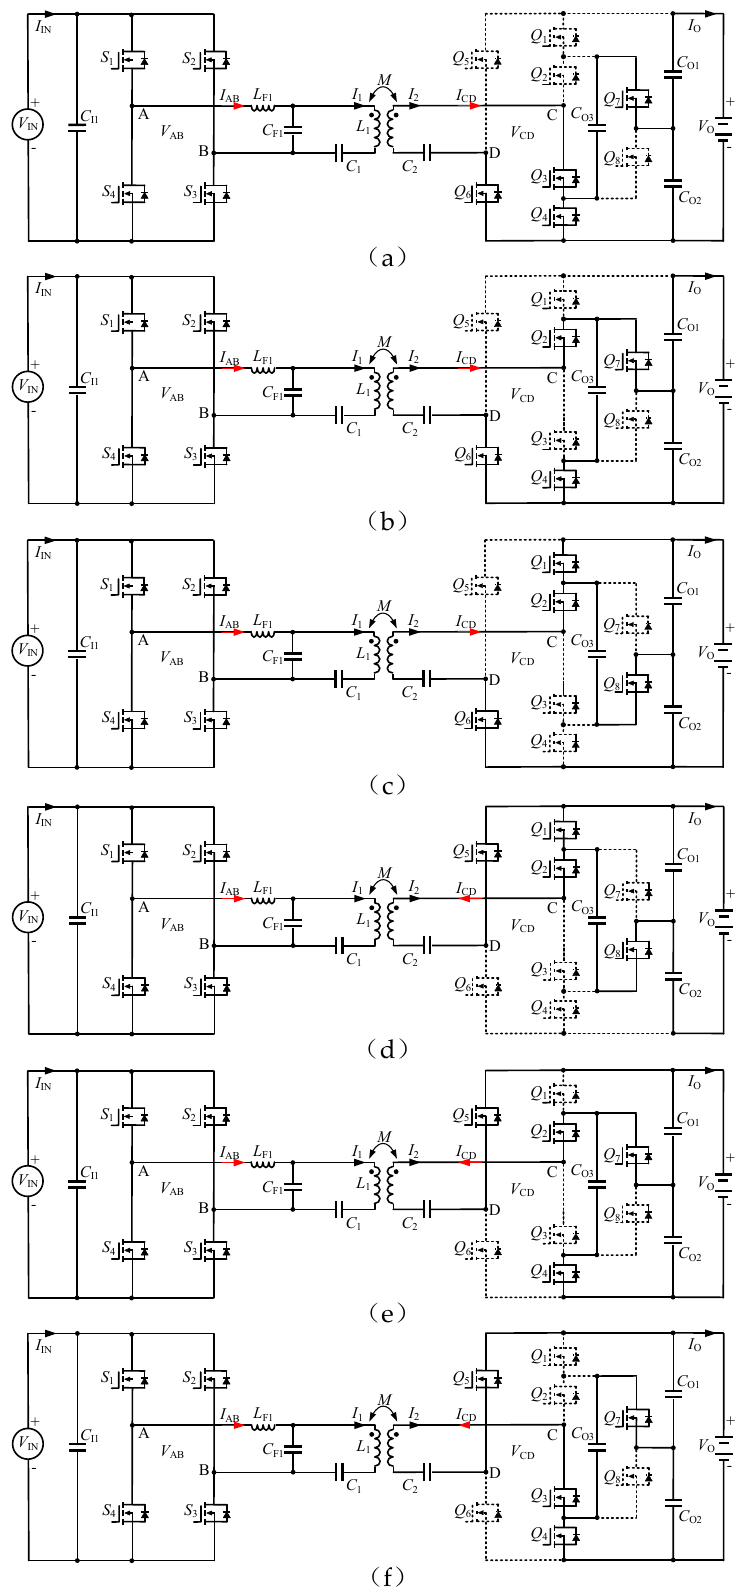
Figure 3. Operating modes in one switching cycle: ( a ) Mode A, ( b ) Mode B, ( c ) Mode C, ( d ) Mode D, ( e ) Mode E, and ( f ) Mode F.